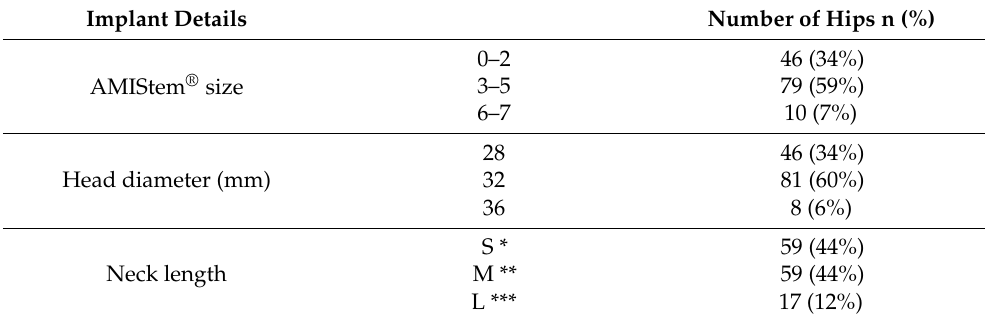
Table 2. Implant